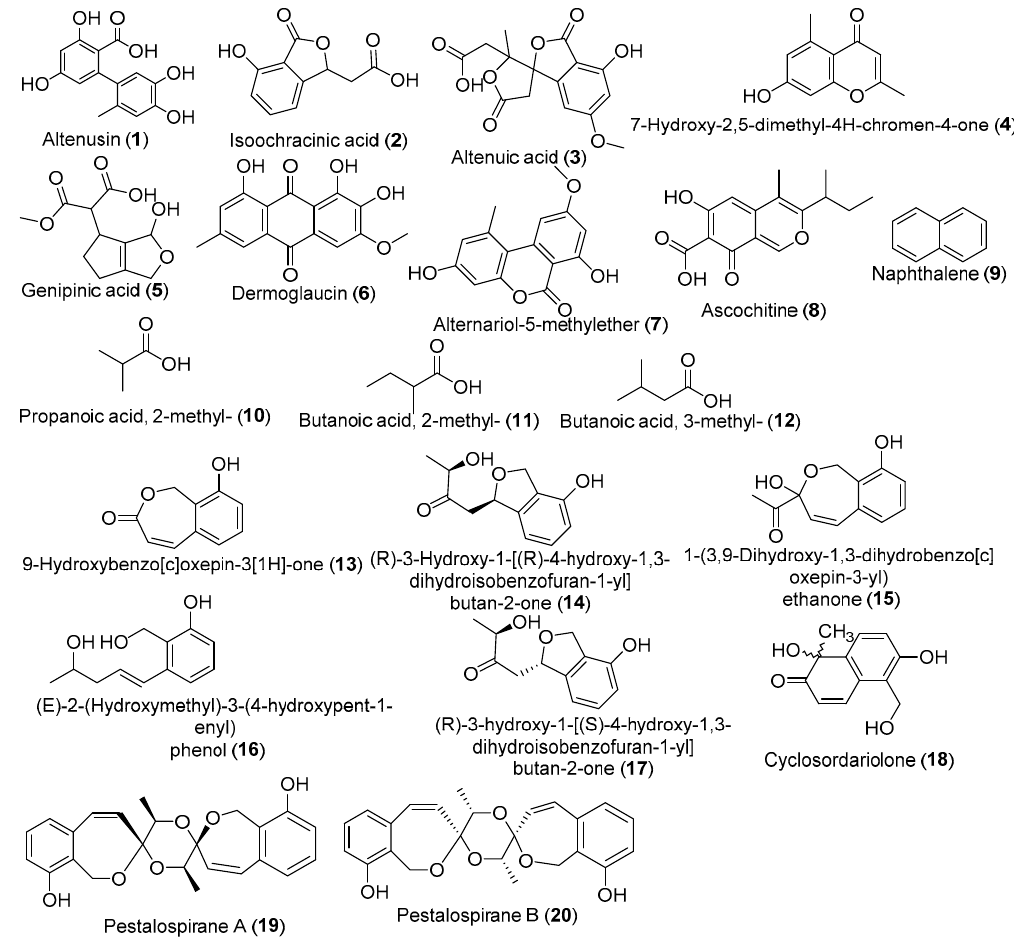
Figure 1. Diverse antimicrobial metabolites produced by endophytic fungi from the Terminalia